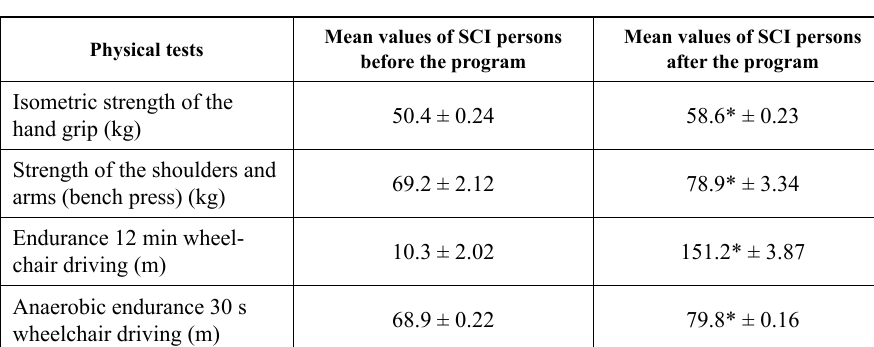
Table 2. Values of